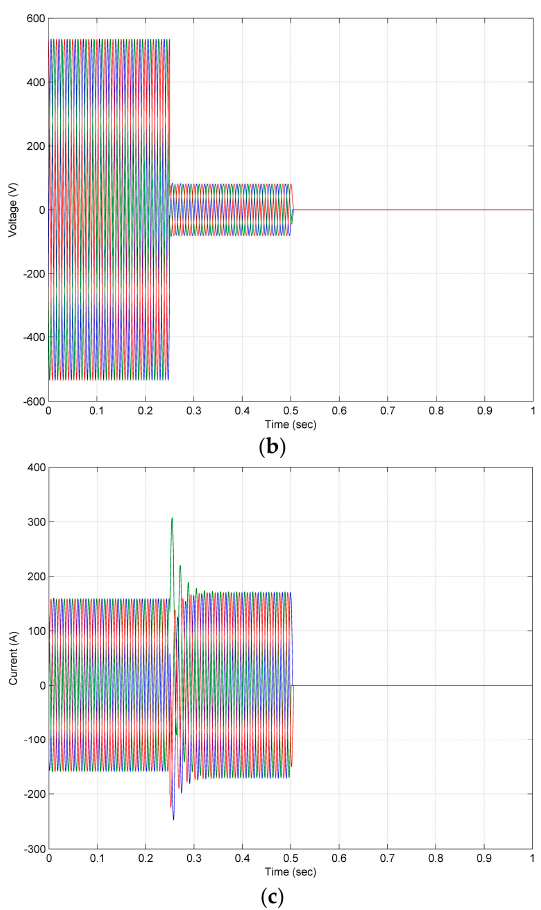
Figure 11. ( a ) CB11 CLOSE/TRIP state; ( b ) Feeder voltage waveforms of CB11 under grid-connected mode, fault occurrence at Bus 1 and failure trip of CB10; ( c ) Feeder current waveforms of CB11 under grid-connected mode, fault occurrence at Bus 1 and failure trip of CB10.